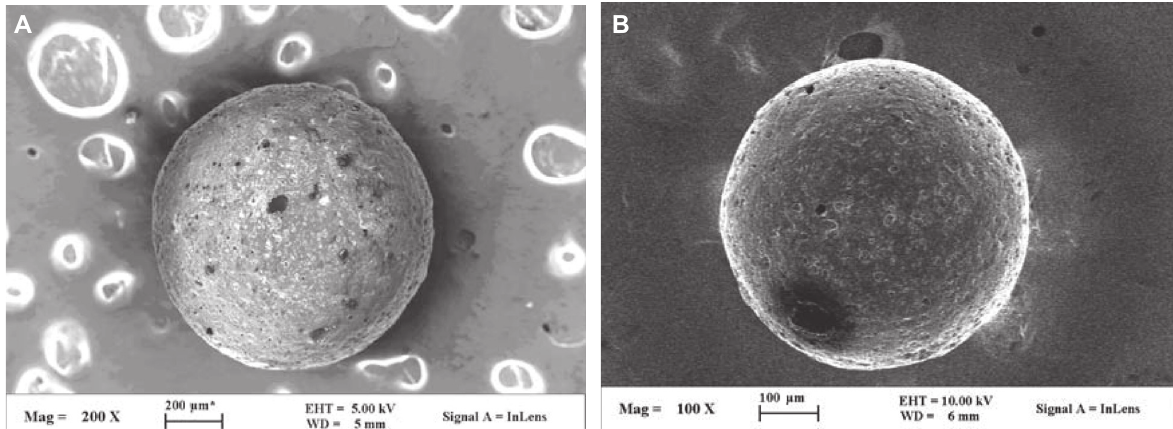
Figure 3 Surface morphology of the 40 wt.% CNTs/PF spheres obtained at (A) 70 ° C and (B) 85 ° C.